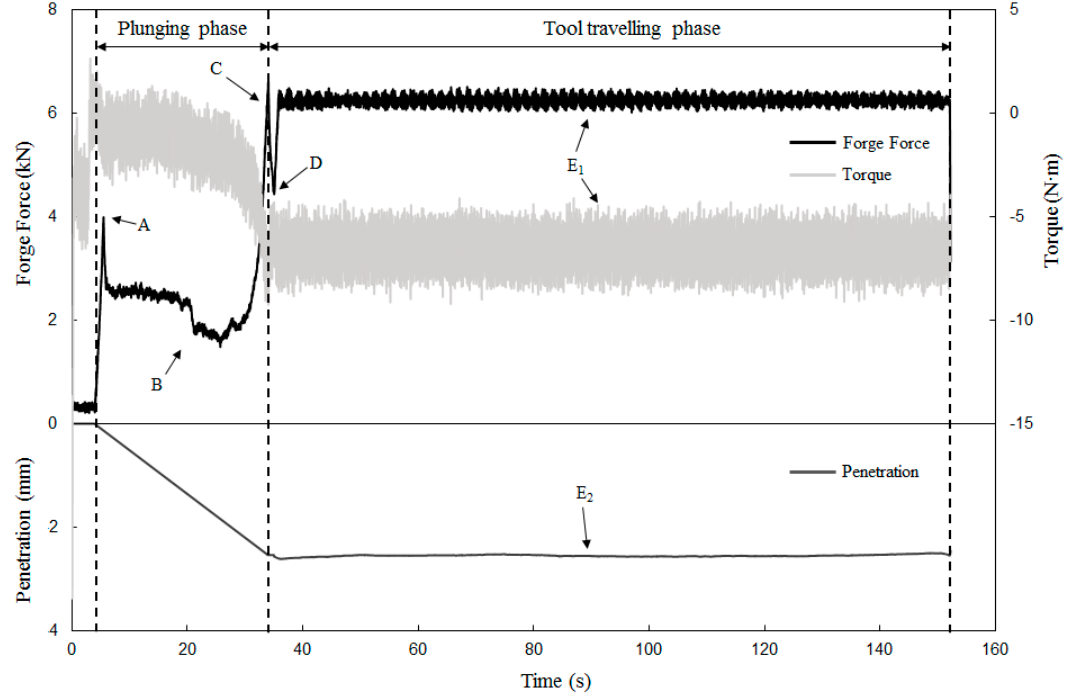
Figure 3. Representation of the forge force, torque, and tool penetration values as a function of time during the FSW process for the coupon C1.